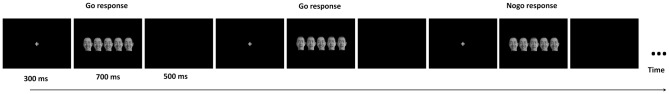
The diagram of experimental stimuli and procedure. In this block, participants were instructed to focus on the central target faces and ignore the bilateral flanked faces, and they were required to execute Go responses to happy faces and Nogo responses to fearful faces. According to the combination rules between Go/Nogo paradigm and flanker paradigm, there were four types of trials, Go_Congruent trials, Go_Incongruent trials, Nogo_Congruent trials and Nogo_Incongruent trials.